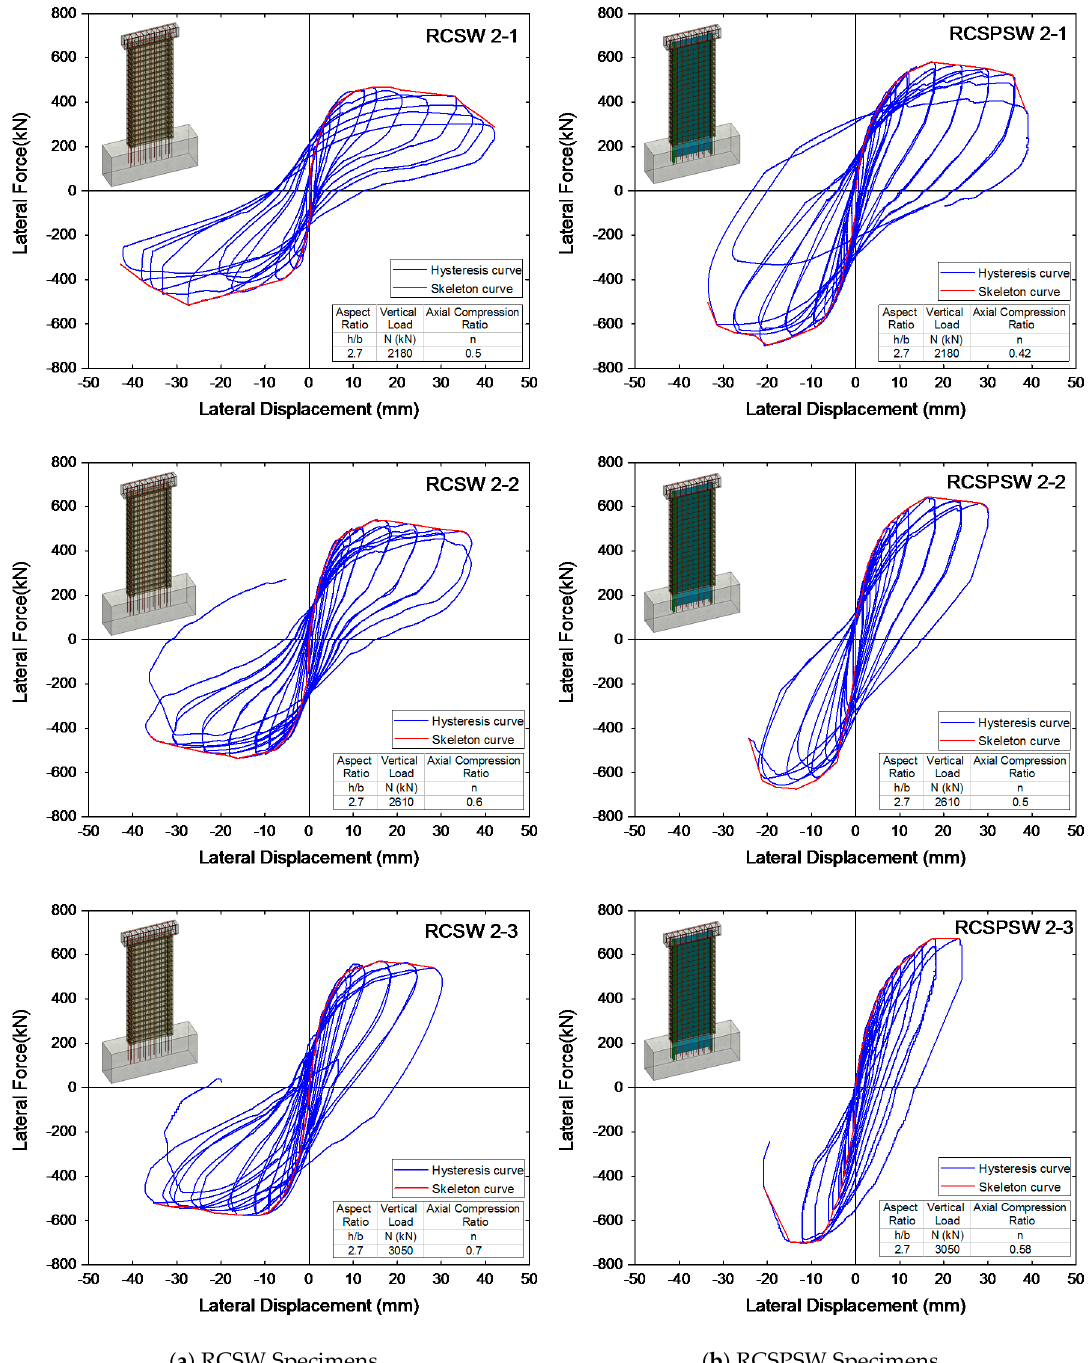
Figure 12. Hysteresis and Skeleton Curves for Specimens with Aspect Ratio of 2.7 ( a ) RCSW Specimens and ( b ) RCSPSW Specimens.